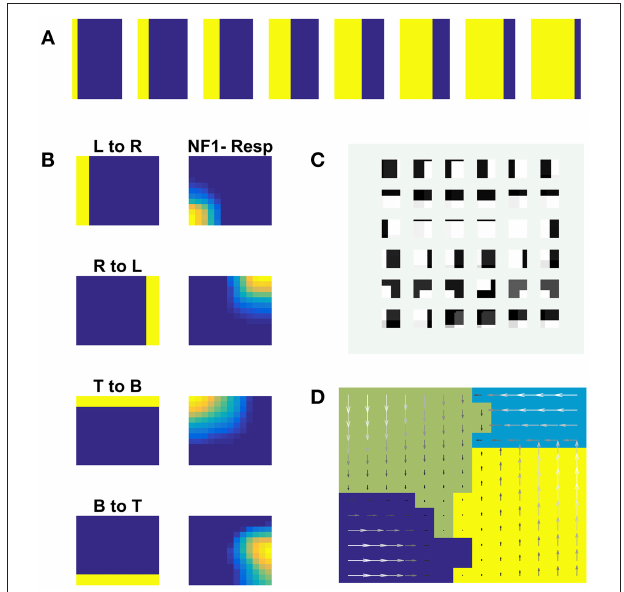
FIGURE 4 | NF1 neuron preferences to moving edge stimuli. NF1 of the two-NFs network is trained using moving square stimuli. 24 × 24 pixel white square is moved on 64 × 64 pixel black background. As neurons in NF1 has small receptive fields (12 × 12 pixels), at any instance, it can see a part of a square and become selective to local motion cues also called component motion which is an edge motion in this case. (A) Sample input of an edge (64 × 64 pixels) moving from left to right. An edge can be moved in four possible directions [left to right (L to R), right to left (R to L), top to bottom (T to B) and bottom to top (B to T)] and the response of NF1 to an edge motion is displayed in (B) . Even though NF1 is trained using moving square objects, most of the NF1 neurons tuned to local edge motion (i.e., component motion). (C) Depicts the trained afferent weights (12 × 12 pixel each) for the selected neurons. (D) Topographic map formed out of NF1 response to edge motion: The arrows indicate the neuron preferences in the direction of edge